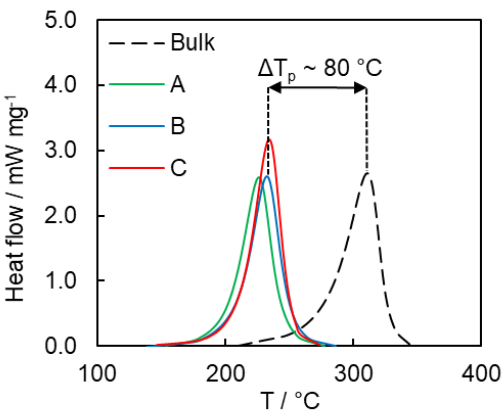
Figure 7. Heat flow curves for bisphenol E cyanate ester polymerization in bulk and nanoconfined states at 7.5 ◦ C min − 1 . ∆ T p shows the magnitude of the di ff erence in the peak temperatures of the respective DSC curves.